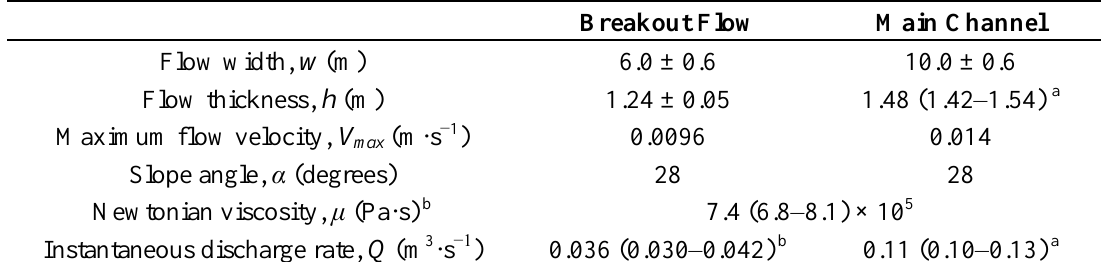
Table 1. Breakout flow and main channel